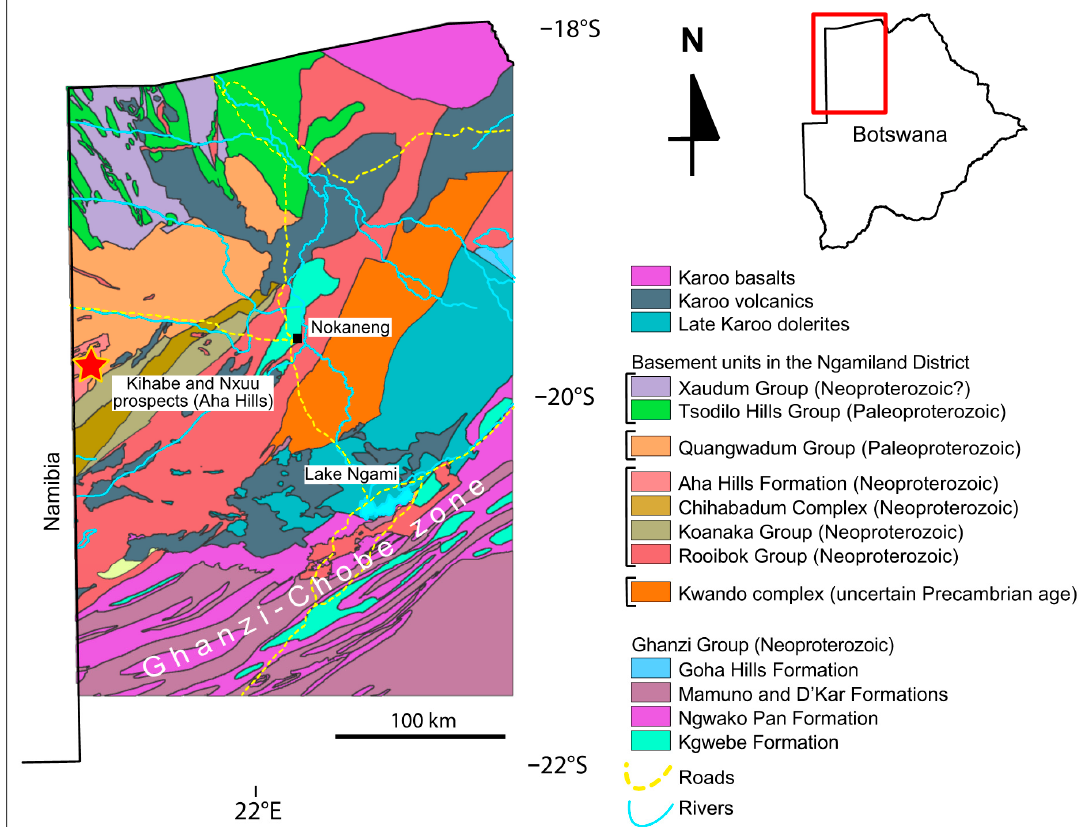
Figure 2. Subsurface geological map of northwestern Botswana, with the location of the Kihabe and Nxuu prospects (modified from [13]). The Kalahari cover is not shown.